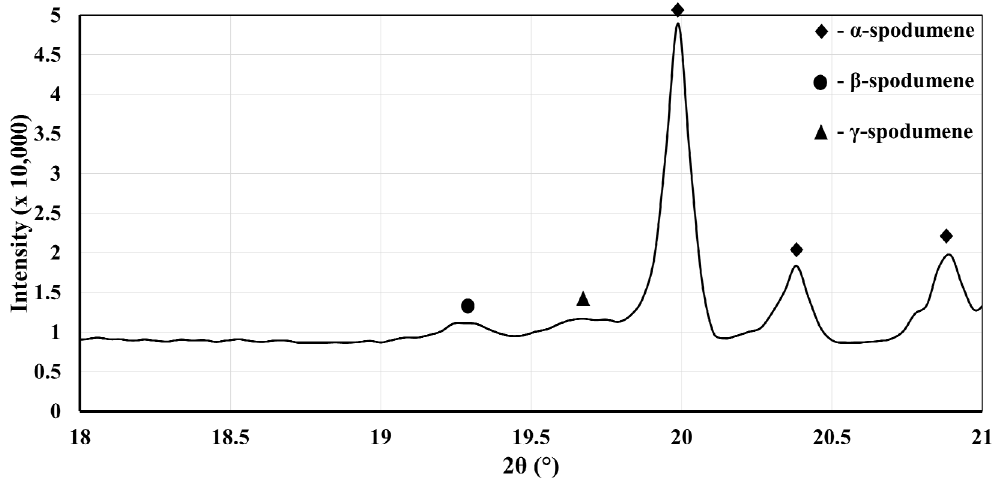
Figure 5. XRD pattern of the 950 °C, 1h sample focusing on the peaks for β -spodumene and γ - spodumene.